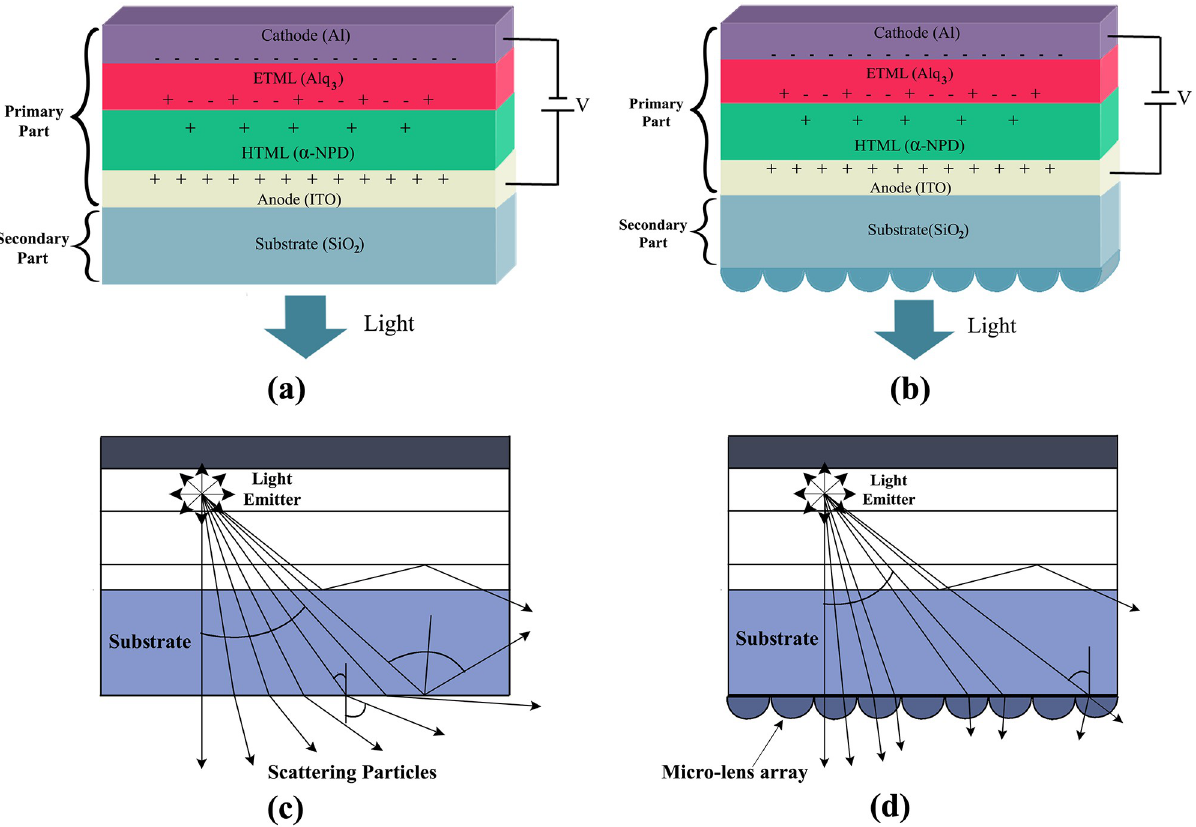
Fig 2. (a) Schematic diagram of primary OLED model; (b) Schematic illustration of micro lens array engraved OLEDs; (c) Light trapping in the substrate layer of basic OLED due to total internal reflection [30] and Improvement of light efficiency and intensity of OLEDs using MLA [30].